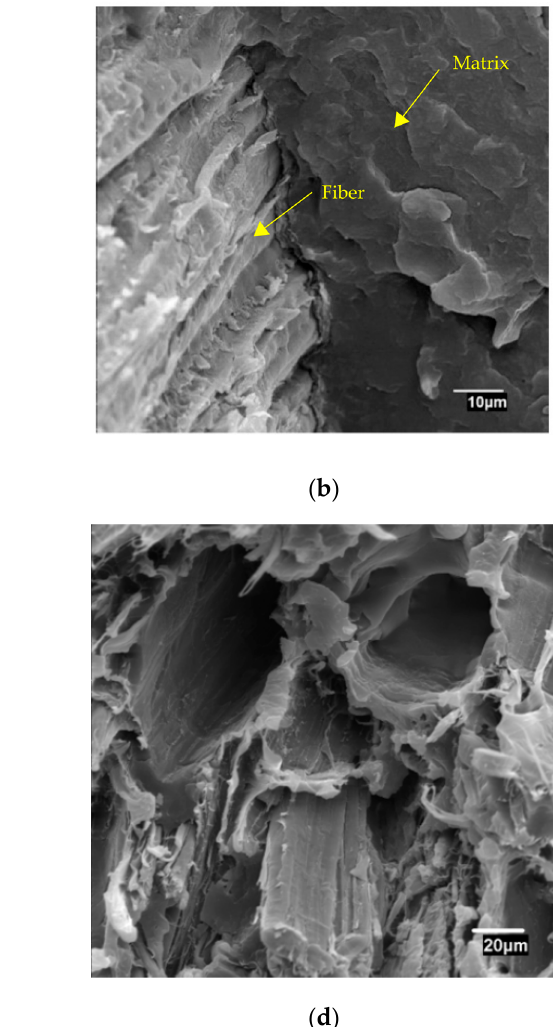
Figure 4. SEM micrographs of the fracture section of specimens with 40 wt% of HS; ( a , b ) added 8 wt% of MAPP coupling agent; ( c , d ) added 4% of MAPP coupling agent.